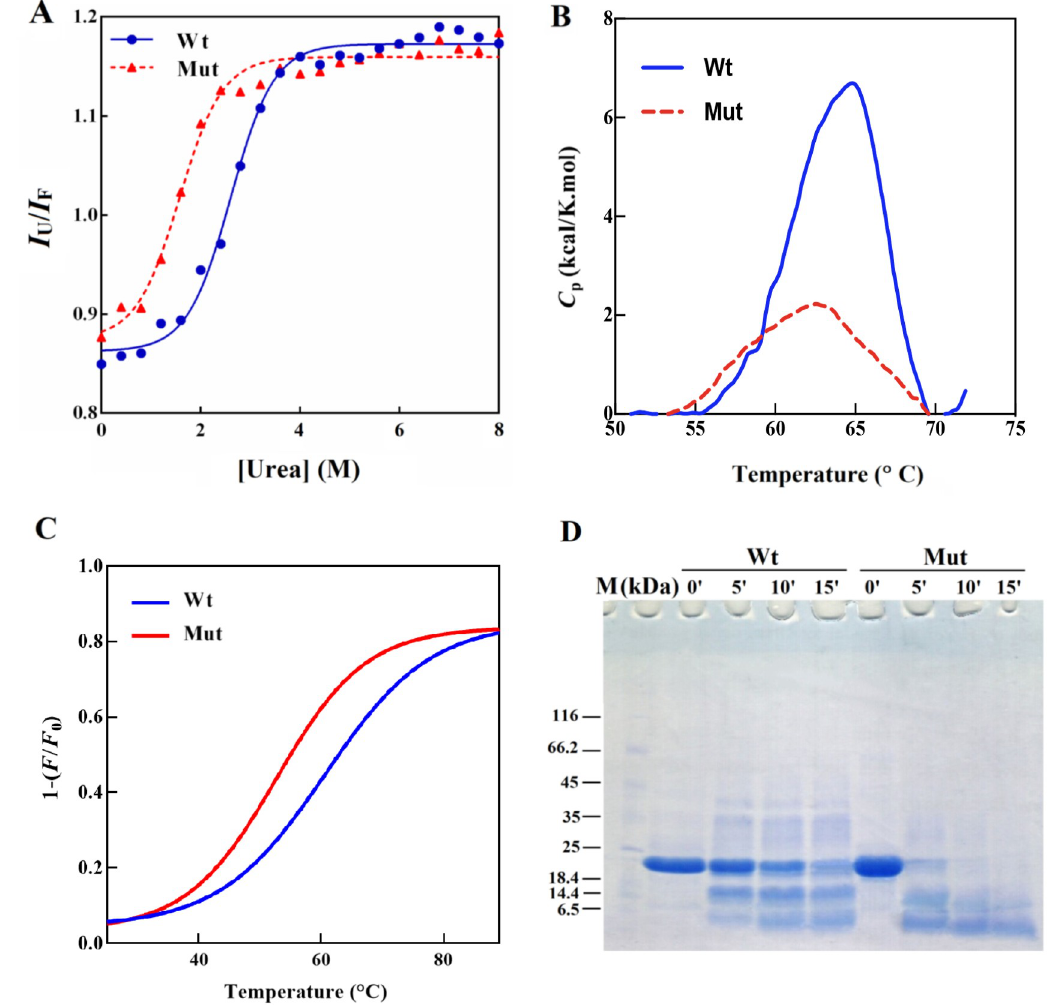
Fig 10. The stability assessment of D109A mutant and wild-type human α B-crystallins. A ) The stability of protein samples against chemical denaturation. Protein samples were incubated with an increasing concentration of urea (0–8 M) for 18 hours and the tryptophan fluorescence spectra of all samples were recorded. B ) Thermal-stability of human α B-crystallins was measured by DSC. The plots display the heat capacity changes ( Δ C p ) of the different α B-crystallin proteins against various temperatures. C ) Thermal stability assessment of α B-crystallin proteins by Intrinsic Trp fluorescence assay. D ) The stability of protein samples against the proteolytic activity of α -chymotrypsin. The protein samples were incubated with the protease for 5, 10 and 15 minutes at 37 ˚C.